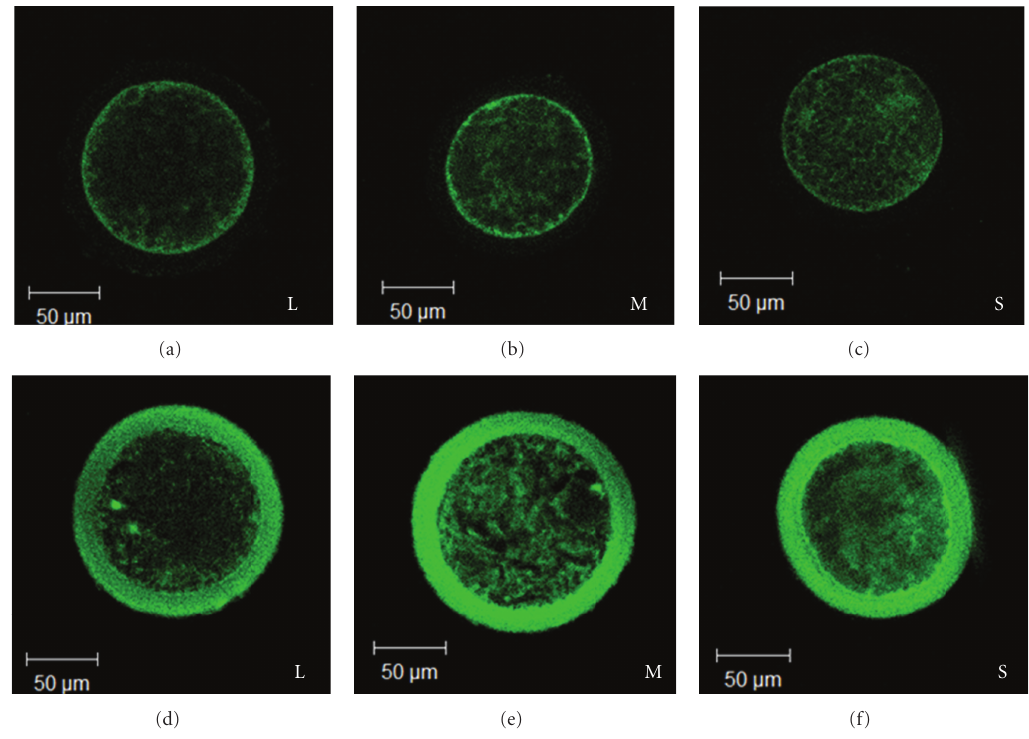
Figure 2: Confocal microscopic observation of INHA cellular distribution in porcine oocytes isolated from small, medium, and large follicles before and after IVM. Porcine oocytes isolated from small, medium, and large follicles were stained before and after IVM with porcine INHA (before IVM; (a), (b), and (c) and after IVM; (d), (e), and (f)), (goat polyclonal anti-INHA, sc-22048). The treated oocytes were labeled for 40min with FITC-conjugated anti-goat IgG Ab, which emits a green fluorescent signal after excitation at 488nm at a 1:200 dilution in PBS. Bars are 50 μ m. L: large, M: medium, S: small